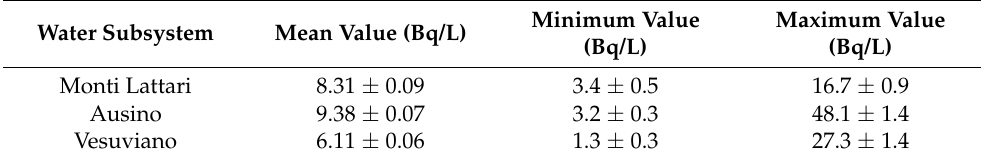
Table 9. Mean values of radon activity concentration for each water subsystem